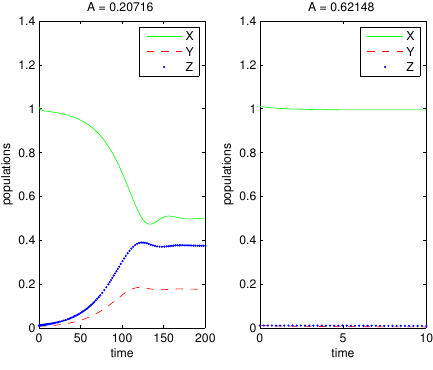
Figure 1. Transcritical bifurcation at F 1 , for the parameter values r = 0 . 6, c = 0 . 38, w = 0 . 47, s = 0 . 4, v = 0 . 5, d = 0 . 2, B = 0 . 48, A = i × 0 . 41432, i = 1 , 2 , 3. On the left the 2 coexistence equilibrium, on the right the equilibrium E 1 .